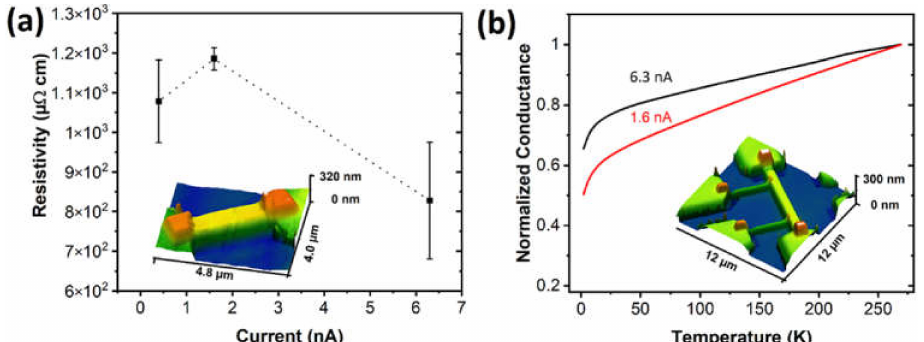
Figure 2. ( a ) Resistivity vs. electron beam current used for FEBID recorded in the SEM chamber after the material growth. The devices are investigated in a two-point configuration, as illustrated in the AFM image of the FEBID deposit bridging Au microelectrodes. ( b ) Temperature dependence of the conductance normalized at 285 K for V-based FEBID samples prepared at 1.6 nA and 6.3 nA at 5 kV, respectively. The AFM image in the inset shows a typical deposit used for these studies based on four-terminal